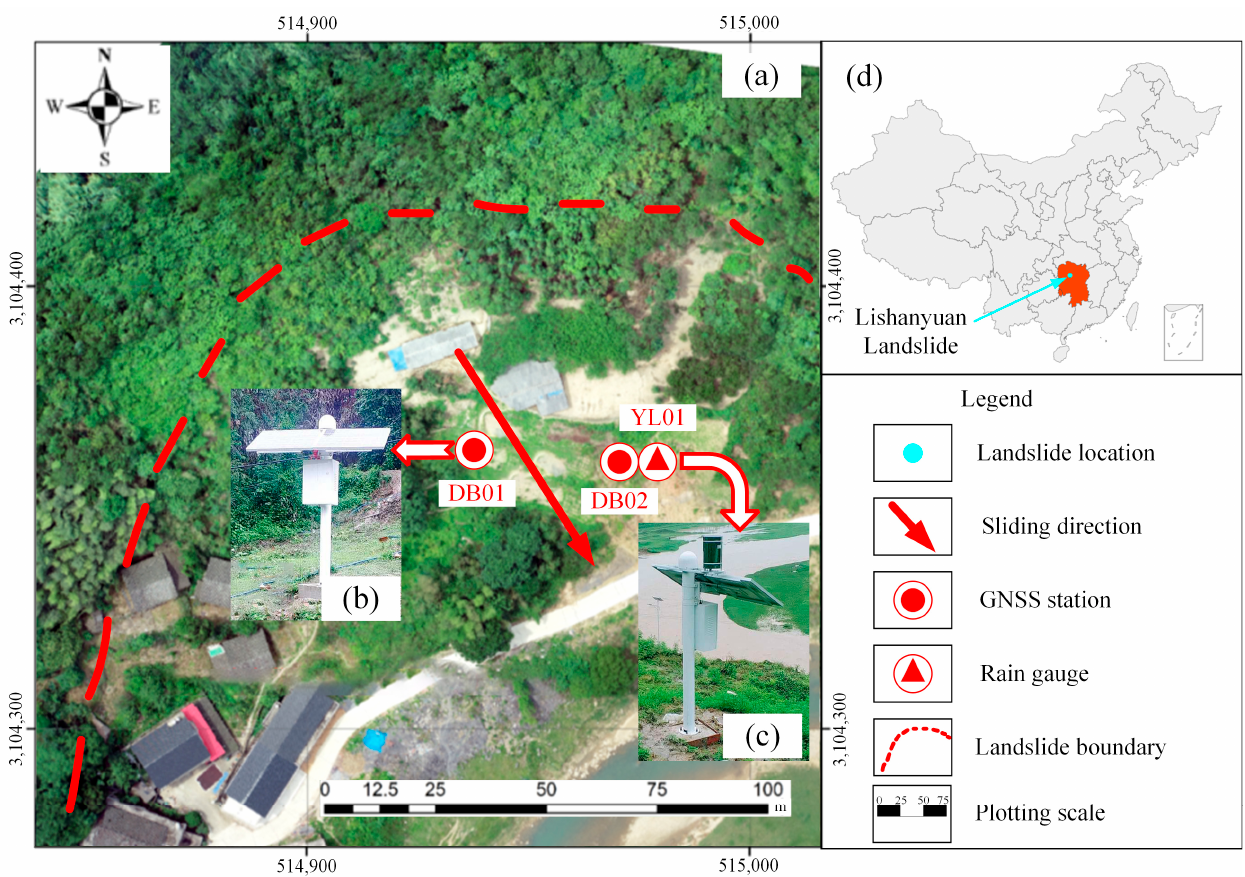
Figure 2. Geographical location and monitoring scheme of Lishanyuan landslide. ( a ) Site photograph of the Lishanyuan landslide. ( b ) Geographical location of the Lishanyuan landslide. ( c ) Photographs of monitoring stations DB02 and YL01. ( d ) Photograph of the DB01 monitoring station.